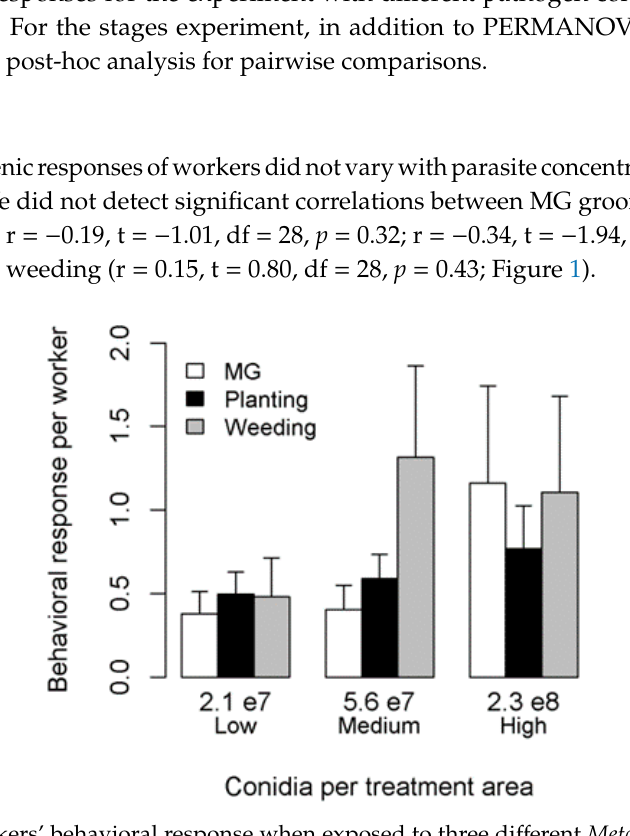
hygienic behaviors when comparing Metarhizium and Escovopsis (F 1,39 = 2.7, p = 0.06; Figure